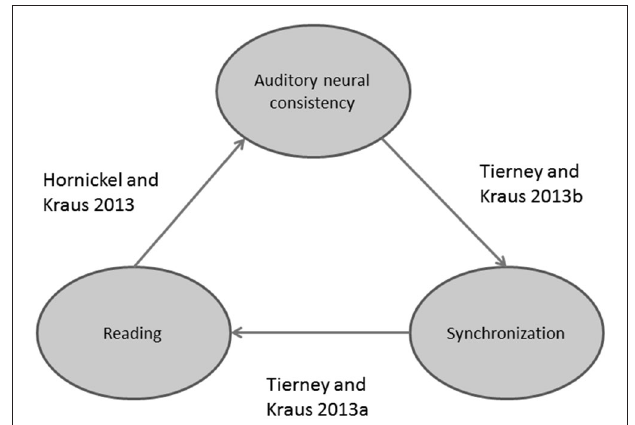
FIGURE 4 | Schematic displaying recently discovered relationships between reading, auditory-motor entrainment, and auditory neural consistency